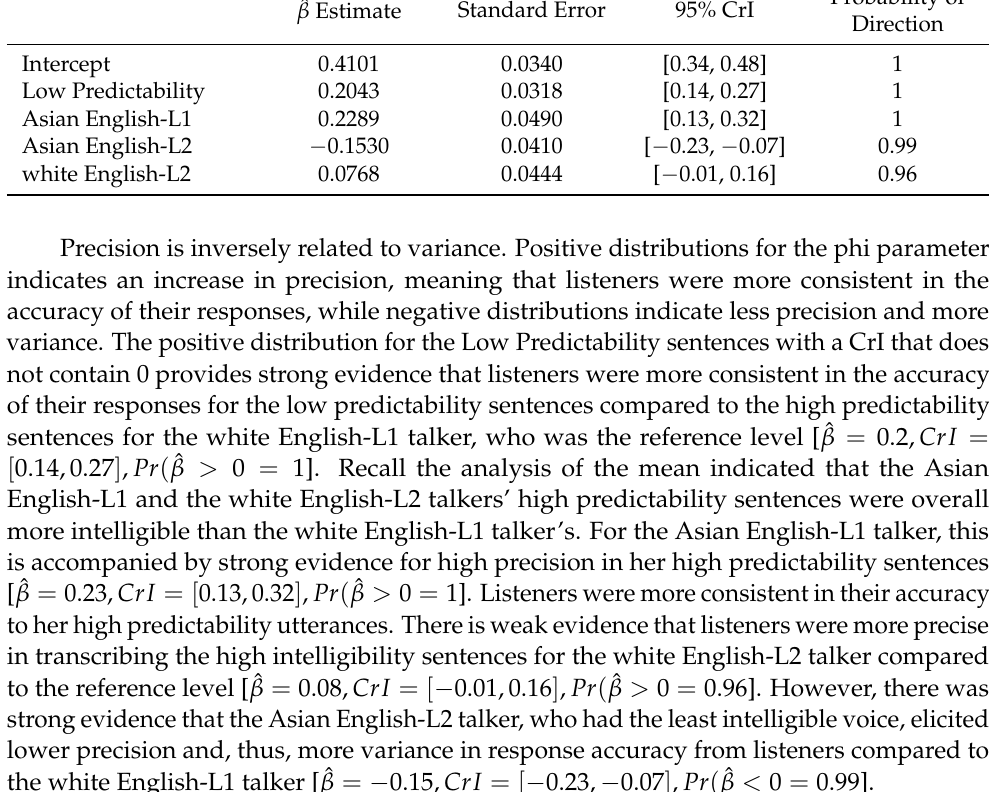
Table 2. Population-level or fixed-effect predictors for the beta regression model. The ˆ β estimate, standard error, and 95% Credible Interval (CrI) for TSR are reported for the means and phi parameters. Mean ˆ β Estimate Standard Error 95% CrI Probability of Direction Intercept 1.4553 0.0857 [1.29, 1.62] 1 Low Predictability − 0.0030 0.1013 [ − 0.2, 0.2] 0.52 Asian English-L1 0.8227 0.0619 [0.71, 0.94] 1 Asian English-L2 − 0.5695 0.0612 [ − 0.69, − 0.45] 1 0.3731 0.0594 [0.26, 0.48]